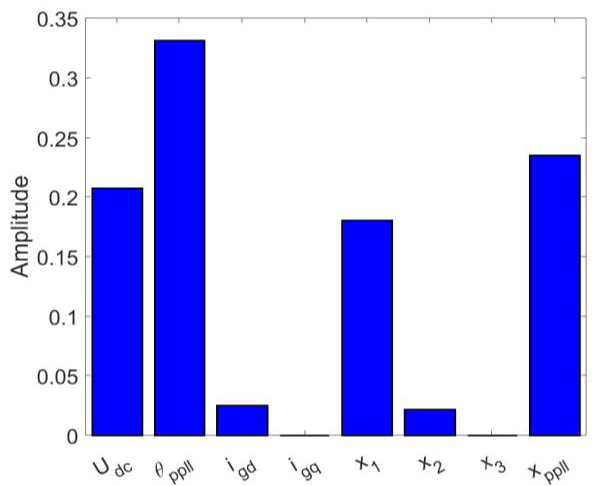
Figure 14. Participation factors of SSR modes with k ipll = 3.